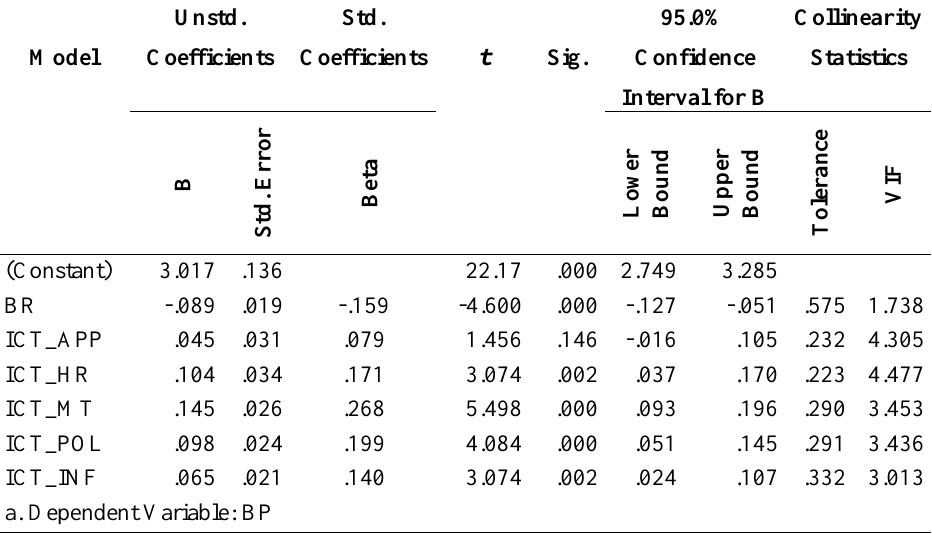
Table 5: Assessment of Structural Model for Collinearity Issues